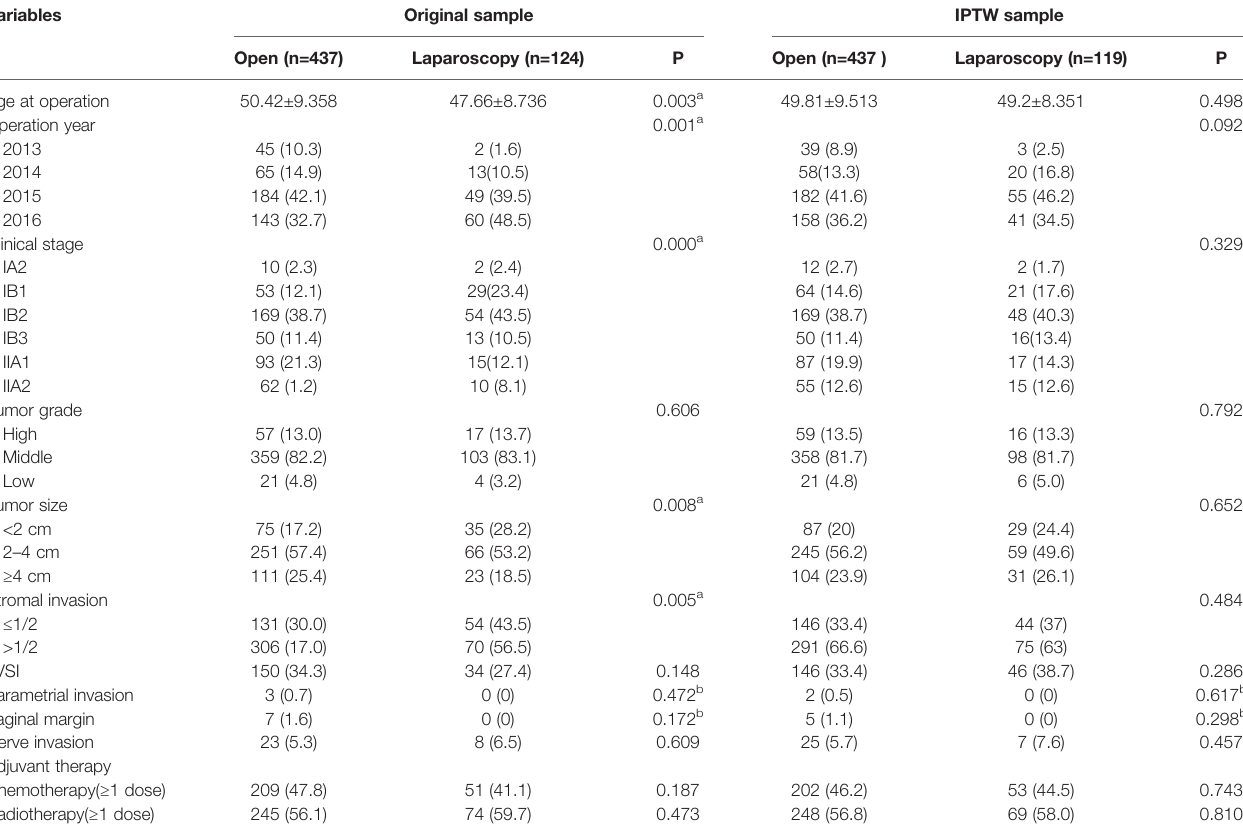
FIGO, Federation International of Gynecology and Obstetrics; IPTW, Inverse Probability of Treatment Weighting; LVSI, lymphovascular space invasion. a P < 0.05; b Fisher exact examination.